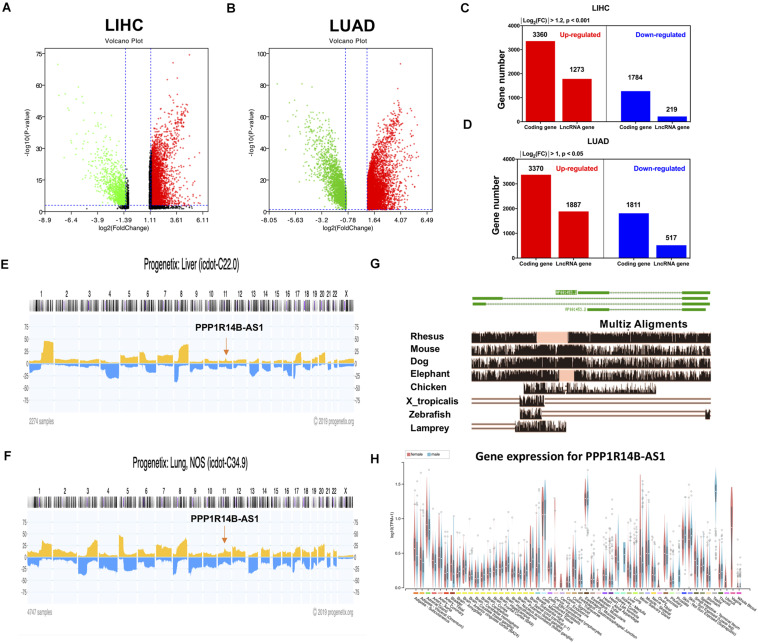
LncRNA PPP1R14B-AS1 was abnormally expressed in LIHC and LUAD. (A,B) Volcano plots showing differential gene expression in the cancer tissues of patients with LIHC and LUAD vs. normal tissues, cut-off value of LIHC: absolute Log2(fold change) > 1.2 and p < 0.001; LUAD: absolute Log2(fold change) > 1 and p < 0.05. (C,D) Taxonomic statistics of differentially expressed genes in LIHC and LUAD tissues. (E,F) Analysis of the copy numbers of PPP1R14B-AS1 across all chromosomes in 2274 LIHC samples and 4747 LUAD samples by Progenetix. (G) Eight PPP1R14B-AS1 orthologs from 100 vertebrate species monitored via the Multiz Alignments track in the UCSC Genome Browser. (H) PPP1R14B-AS1 expression levels in different normal human tissues provided by GTEx.